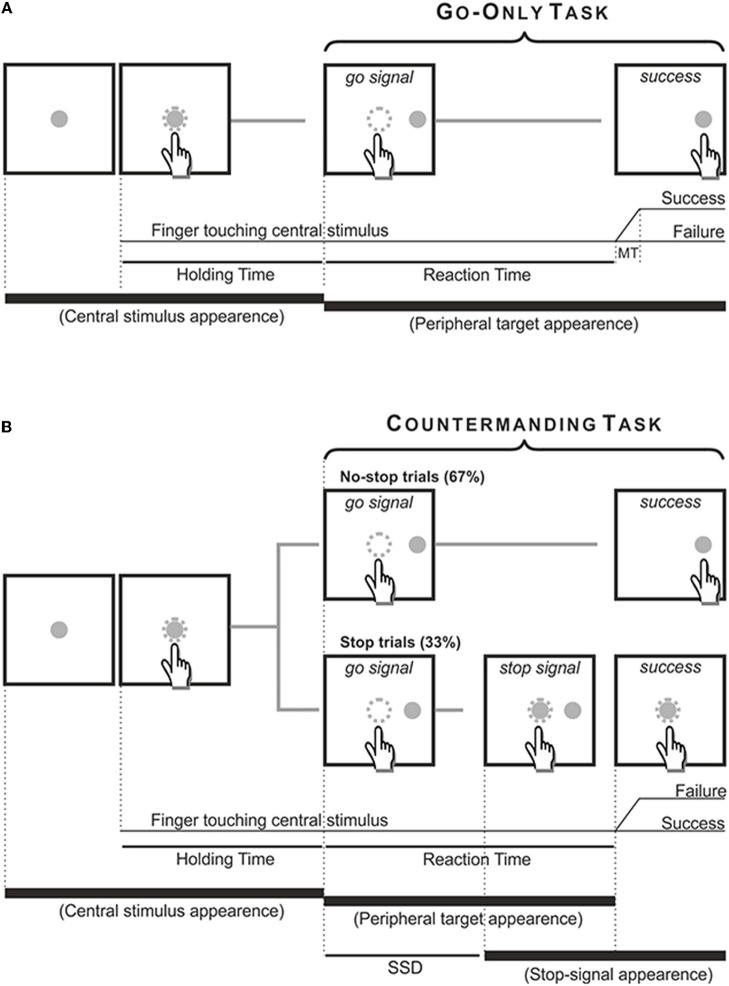
Temporal sequence of the visual displays for go-only, no-stop (A) and stop trials (B). All trials began with the appearance of a central stimulus. The subject had to reach and hold it with the index of the right arm for 500–800 ms. (A) In the go-only task and in the no-stop trials of the countermanding task the central stimulus disappeared and, simultaneously, a target appeared 13.5 cm or 18.6 dva to the right, acting as a go-signal. Subjects were instructed to perform a speeded reaching movement toward the peripheral target and to hold it for 300–400 ms. Randomly, in 33% of trials of the countermanding task [stop trials, (B)] the central stimulus (stop-signal) reappeared at a variable delay after the go signal (stop signal delay, SSD), indicating that the subject should cancel the pending movement. In these stop trials, if subjects countermanded the planned movement keeping the arm on the central stimulus for a period of 400–600 ms, the trial was scored as a stop-success trial. Otherwise, if subjects executed the reaching movement the trial was scored as a stop-failure trial. The dotted circle (which was not visible to the subjects) indicates the size of the tolerance window for the touches (3.5 cm or 5 dva of diameter).